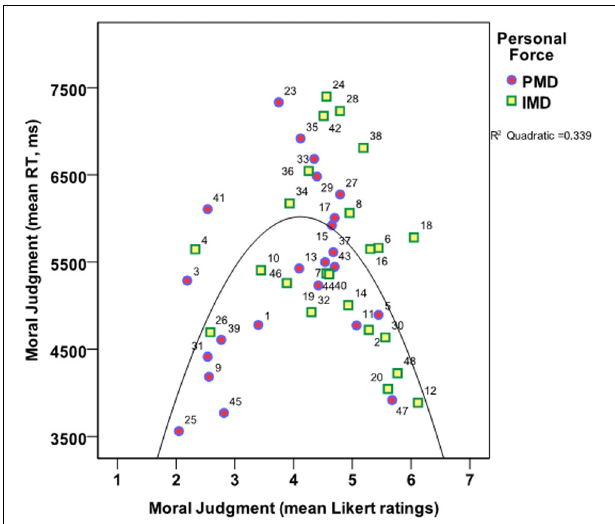
FIGURE 4 | Curvilinar relationship between Moral Judgment and RT. Color coding: Personal Moral Dilemmas (Blue/Red, circles); Impersonal Moral Dilemmas (Green/Yellow, squares). Mean Likert scale responses: 1 = No, I don’t do it , i.e., deontological moral judgment; 7 = Yes, I do it , i.e., utilitarian moral judgment. RT is in milliseconds (ms). PMD, Personal Moral Dilemmas; IMD, Impersonal Moral Dilemmas.